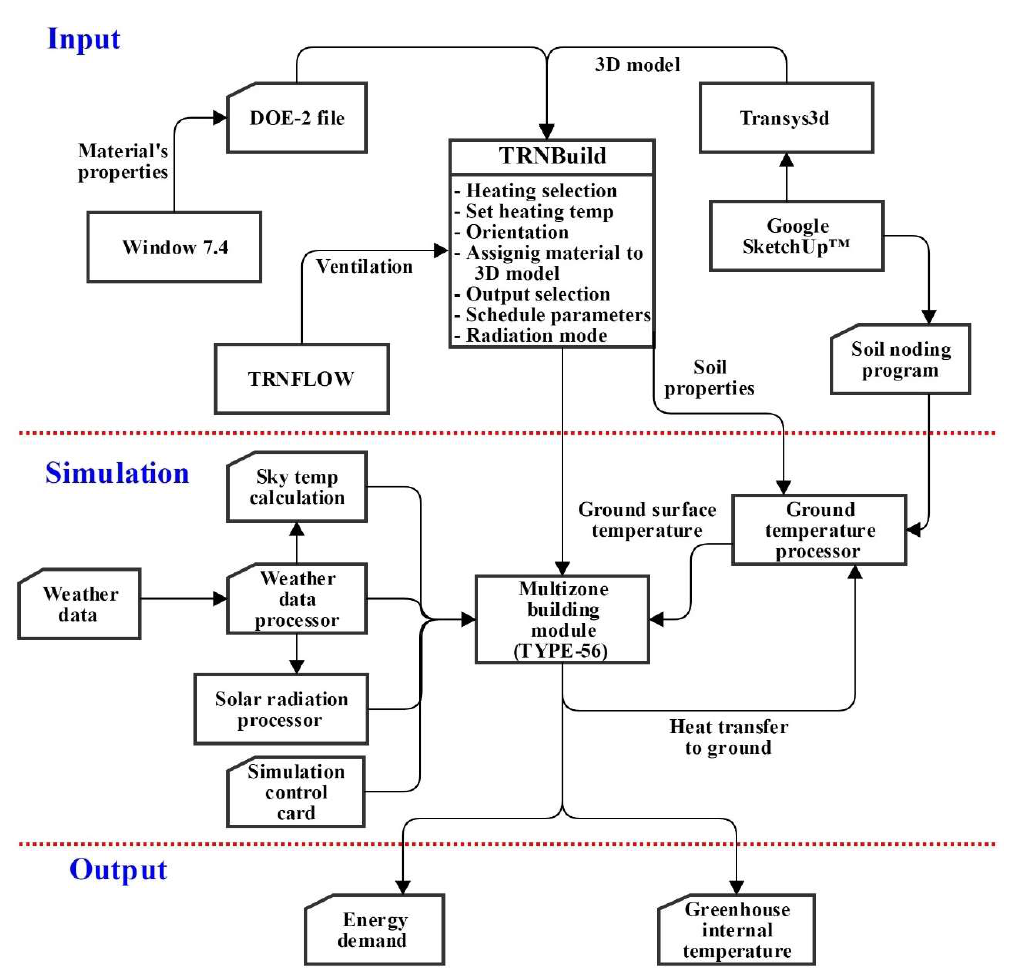
Figure 6. Building Energy Simulation (BES) modeling flow chart using TRNSYS18.